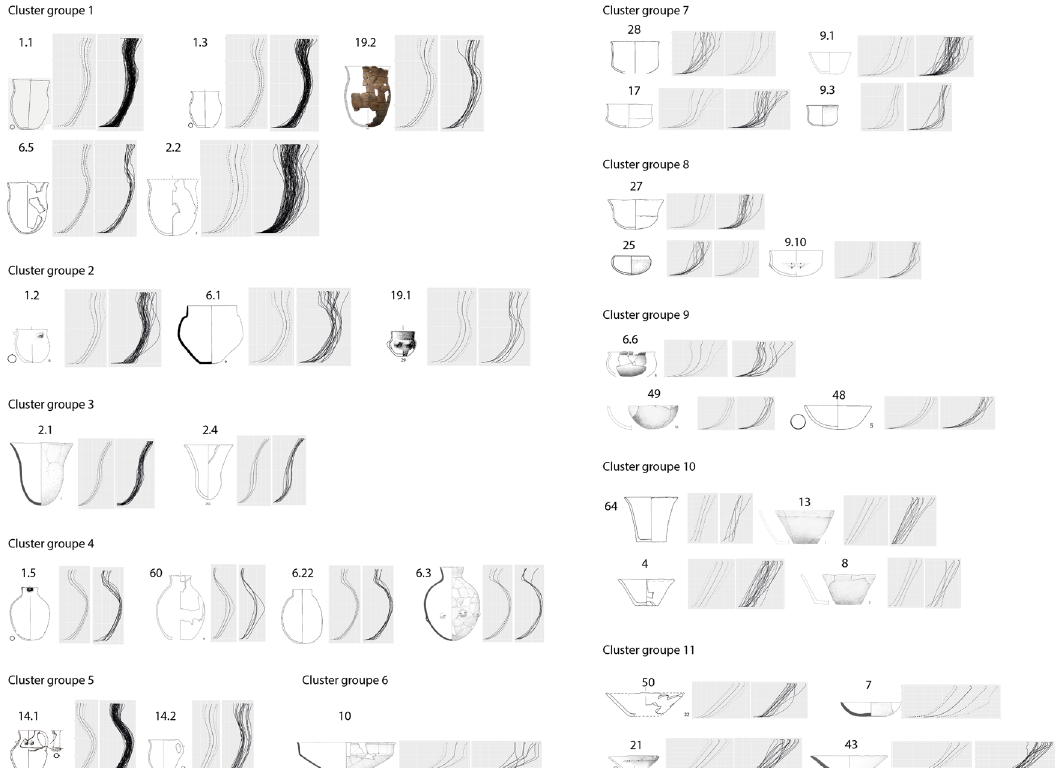
Figure 14: Choosen clusters and subclusters from di ff erent hierarchical level for further research question - dependent analyses within the MET project ( after: C. Heitz, for the picture credits of the pottery drawings see doi: 10.5281/zenodo.7258694 )